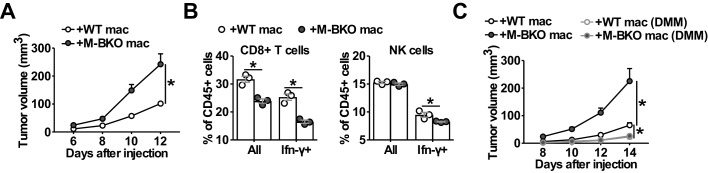
Macrophage Bmal1 modulates the antitumor activity.(A) Tumor volume in WT male mice co-injected with 500,000 B16-F10 cells and either 500,000 WT or M-BKO macrophages as indicated. N = 22 mice, statistical analysis was performed using two-way ANOVA to compare WT vs M-BKO macrophage co-injection across the time course. (B) Flow cytometric analysis of tumor-infiltrating CD8+ T cells (CD45+CD3+CD8a+ cells, left panel) and NK cells (CD45+CD3–NK1.1+ cells, right panel) stimulated ex vivo with phorbol 12-myristate 13-acetate and ionomycin for Ifn-γ co-staining. Tumors represented in panel (A) were pooled into three groups prior to isolation of infiltrating leukocytes for flow cytometry. Statistical analysis was performed using Student’s T test. (C) Tumor volume in WT male mice co-injected with 500,000 B16-F10 cells and either 500,000 WT or M-BKO macrophages, supplemented without or with dimethylmalonate (DMM, approximately 150 mg/kg body weight per day in mouse diet). N = 8 mice, statistical analysis was performed using two-way ANOVA to compare WT vs M-BKO macrophage co-injection on control diet, or to compare WT macrophage co-injection on the control diet vs WT or M-BKO macrophage co-injection on the DMM-supplemented diet across the time course. Data are presented as mean ± S.E.M. *, p<0.05. Experiments were repeated at least twice.